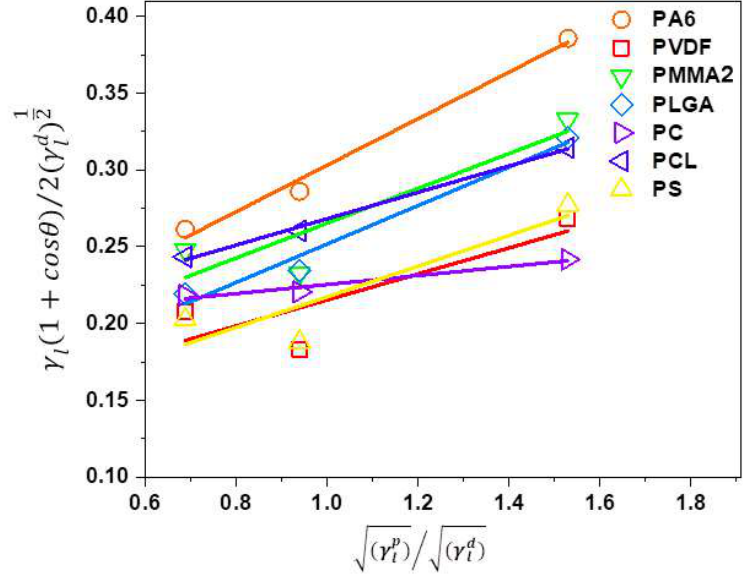
Figure 6. Owens–Wendt plots for all polymer films produced using Equation 2 for three probe liquids of different surface tension. The fitting function for the trend lines is presented in Supporting Information in Table S2. Table 6. Summaries of surface free energy calculated for all polymer films based on Owens-Wendt plots shown in Figure 6 with data found in the literature and references.